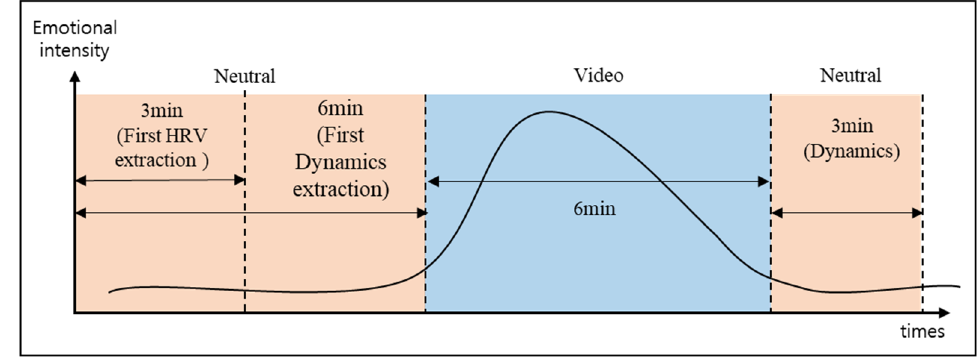
Figure 6. The emotional stimuli structure to extract HRV and dynamics